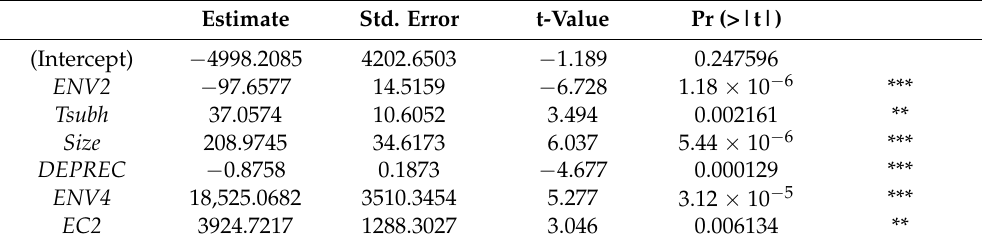
Table 2. Results of regression analysis for the income indicator FNVA/AWU .